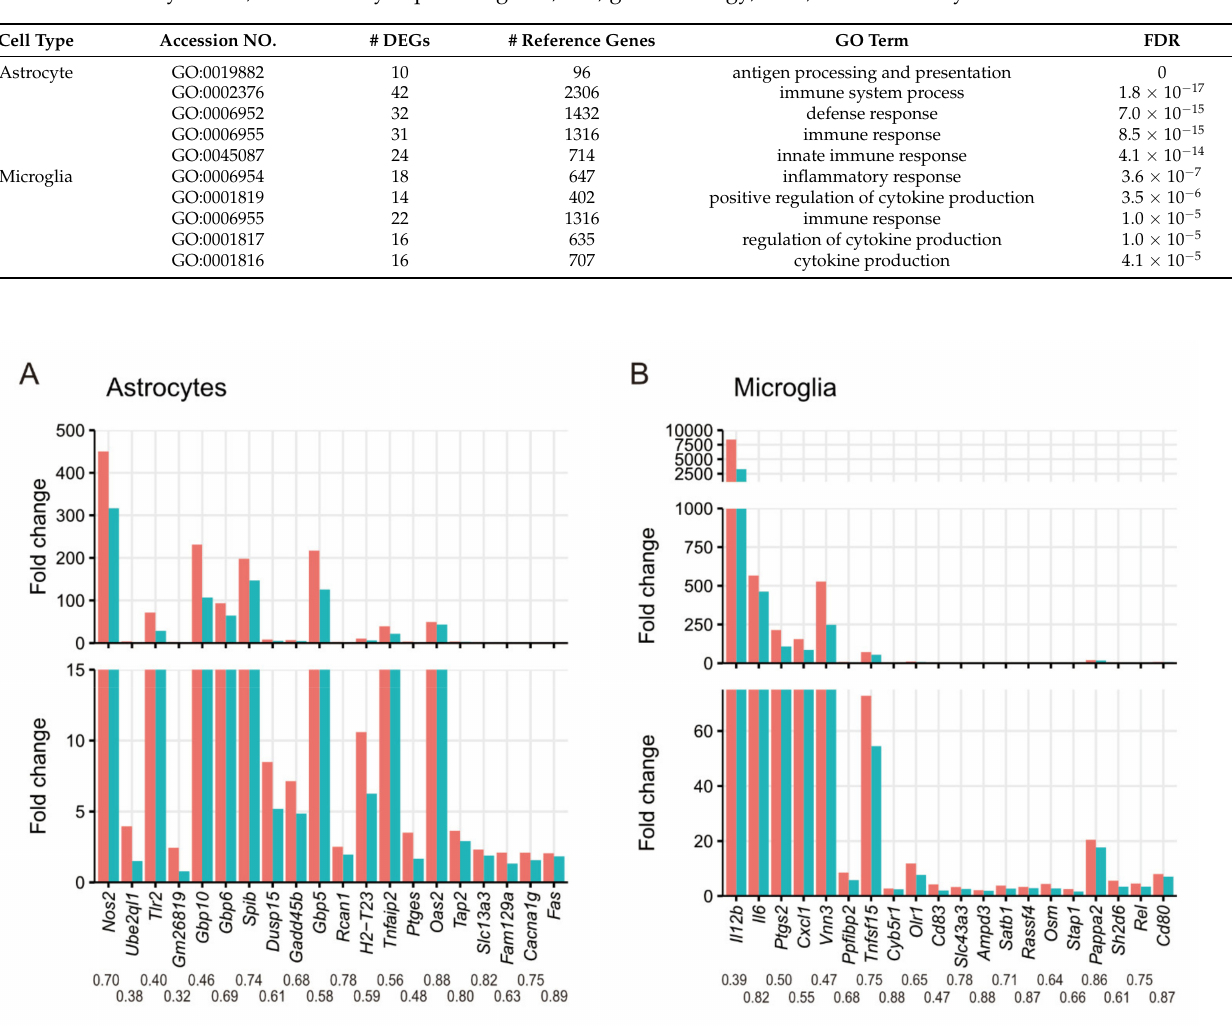
Figure 3. Expression patterns of the top 20 DEGs whose upregulation during T. gondii infection was impaired